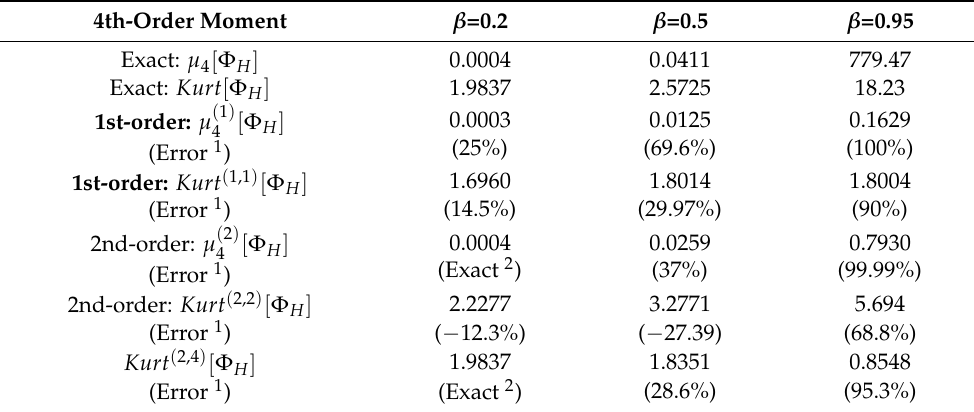
Table 5. Exact and approximate values for the fourth-order moment of Φ H ( σ ; E )